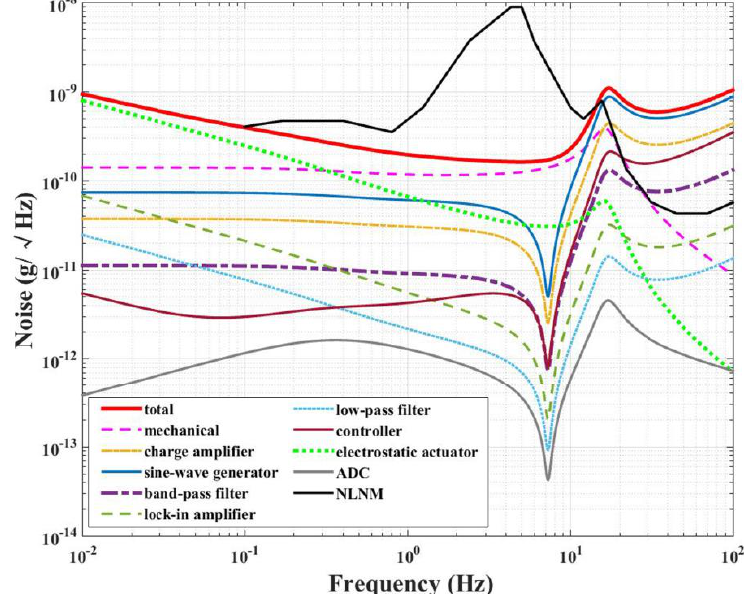
Figure 6. Noise analysis result of the electrostatic accelerometer. The black solid line shows the new low-noise model (NLNM) presented by Peterson [25], and the red solid line shows the calculated total noise of the proposed accelerometer, which is lower than NLNM over the frequency range of 0.1 to 10 Hz.